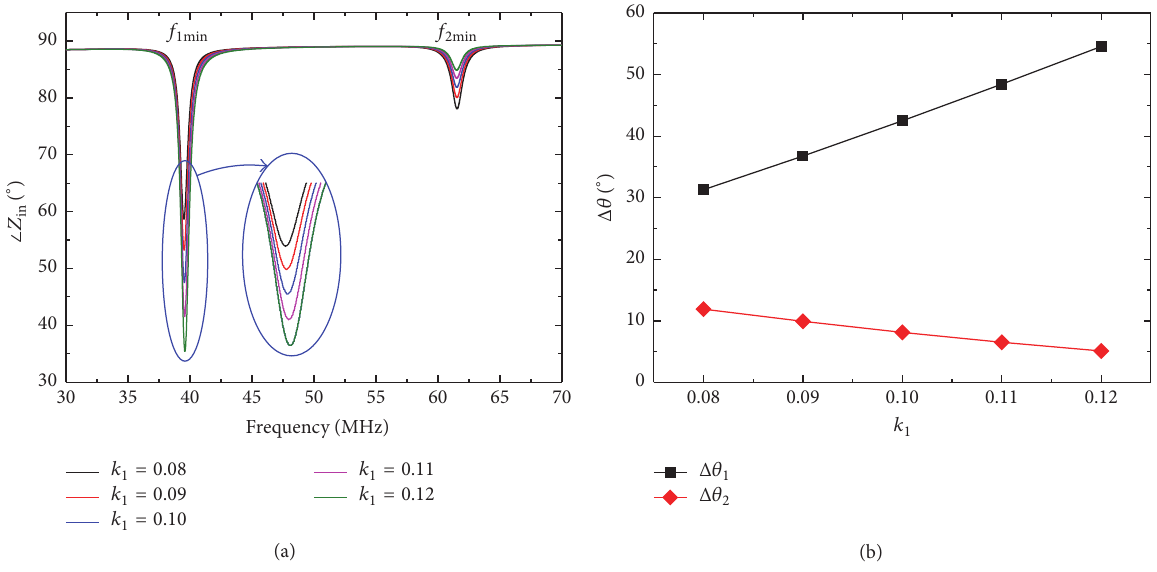
Figure 8: (a) Phase versus frequency curve of the readout coil when the coupling coefficients k 1 increased and (b) the influence of 𝑘 1 on the value of Δ𝜃 1 and Δ𝜃 2